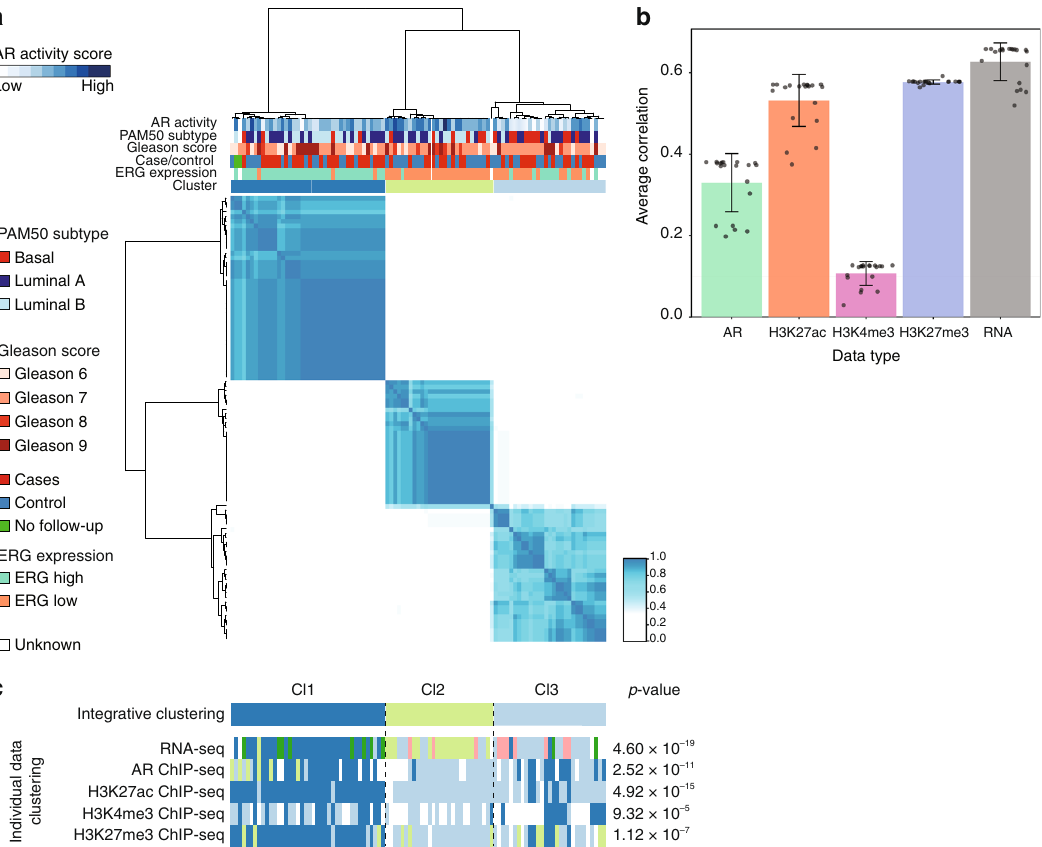
Fig. 4 Integrative clustering of prostate cancer samples. a Heatmap displays the consensus matrix of integrative analysis (MIV-NMF) on the basis of RNA- seq, AR, H3K27ac, H3K4me3, and H3K27me3 ChIP-seq for k = 3 (three clusters). Rows and columns are samples, and the more frequently samples occur in the same cluster, the darker the color blue. b Bar plot showing the Pearson ’ s correlation coef fi cient capturing the contribution of each data type in integrative clustering. Error bars indicate the standard deviation. c The sample classi fi cation into three clusters according to integrative clustering analysis is shown in the top row. The bottom panels show the resultant clustering according to consensus clustering analysis based on each individual data type sorted by integrative cluster assignment. Chi-square tests were used to test for association between the integrative clusters and clusters obtained in